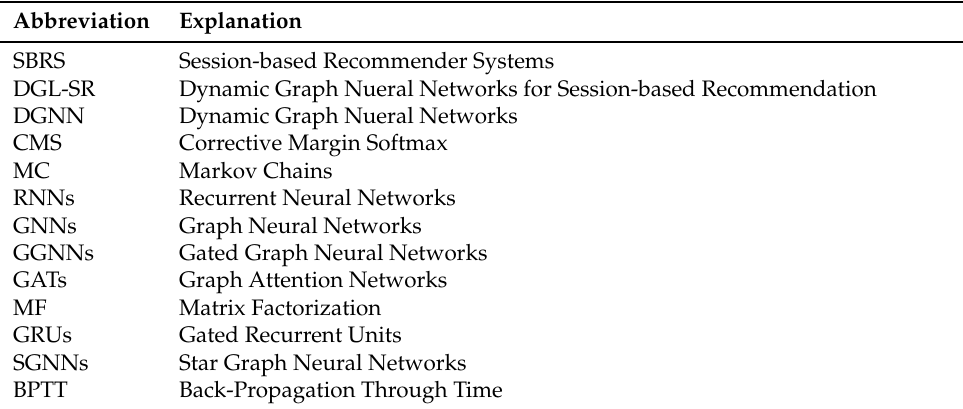
Table 1. Main abbreviations used in this